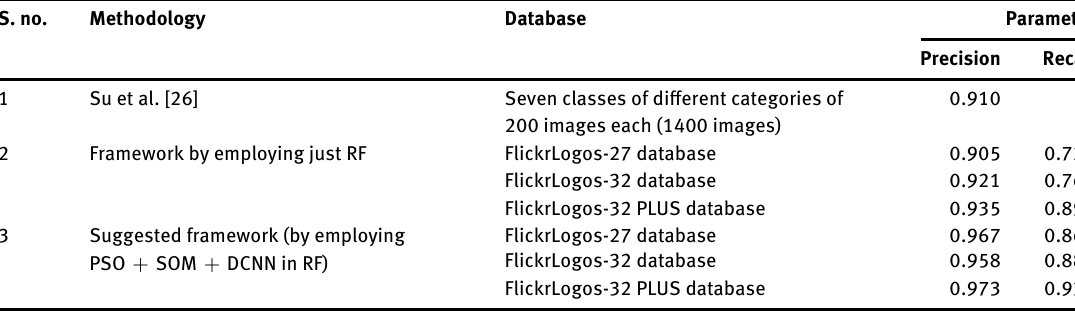
Table 8: Suggested Framework’s Comparison with Su et al. [26]. S.